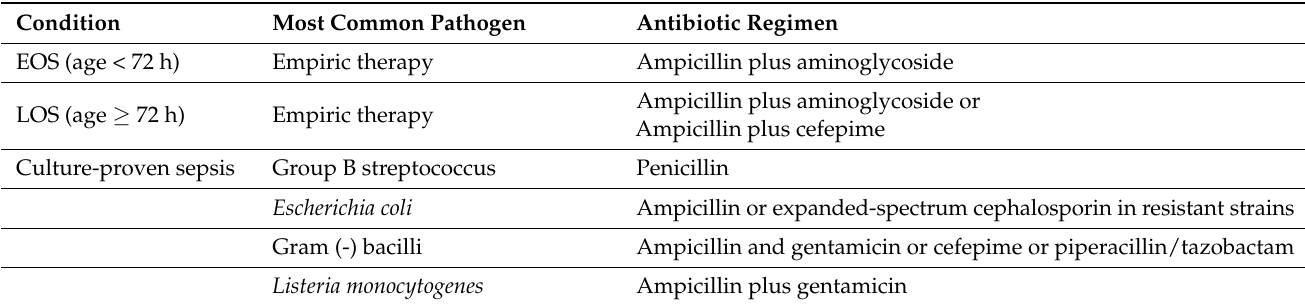
Table 2. Most common antibiotic regimens used in neonatal sepsis [23,48,53,56–58].